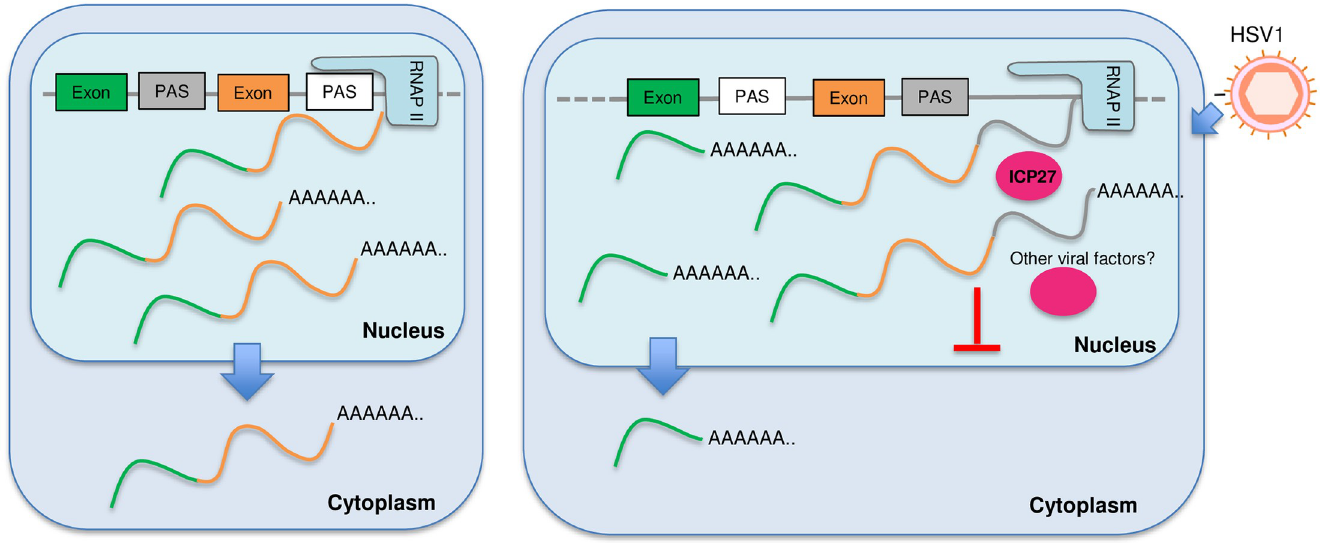
Fig 7. A model for HSV-1-mediated APA regulation. In HSV-1-infected cells, ICP27 and other viral factors induce many APA changes and transcription termination defects. Transcripts that extend beyond the normal TES are cleaved and polyadenylated, but are not exported. Truncated transcripts that are polyadenylated at IPA can be exported into the cytoplasm and translated. Please see text for more details.